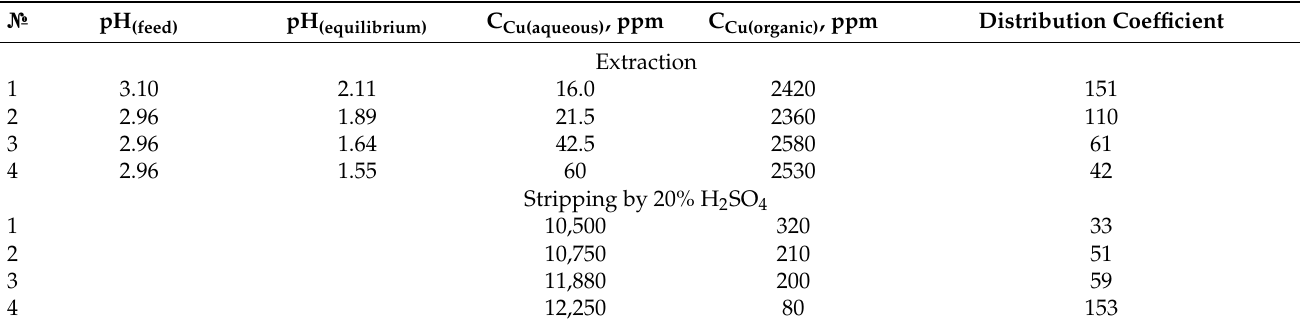
Table 1. Results of copper extraction and stripping in the system with 20% LIX-84 in decane (equilib- rium